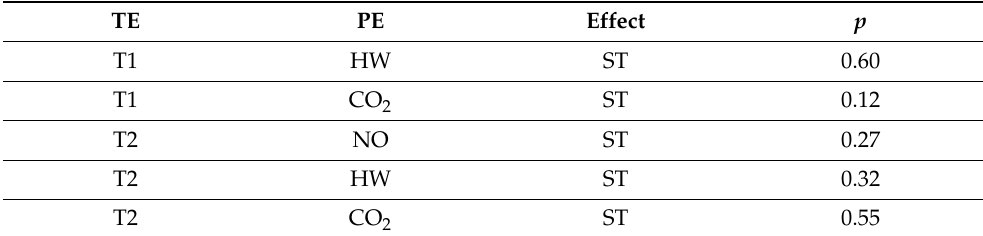
Table 8. Storage time effect—one-way ANOVA *.